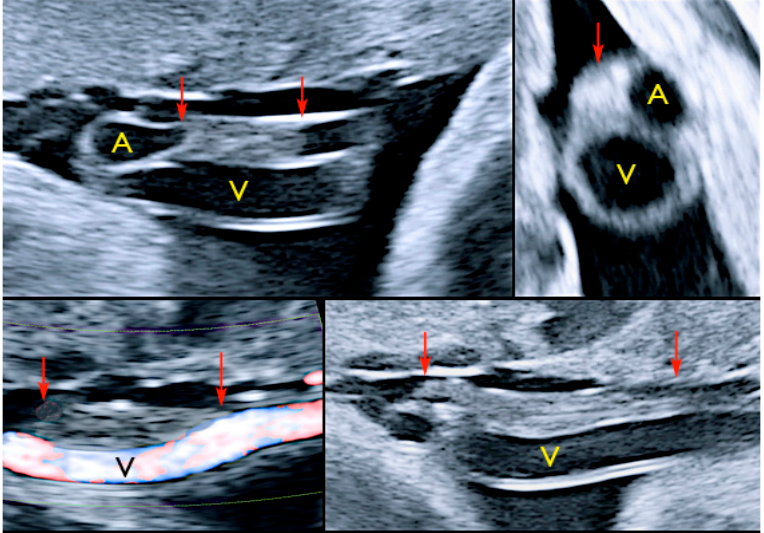
Figure 33. Pregnancy at 32, 34 and 35 week’s gestation. Two-dimensional ultrasound in longitudinal and axial scan of the umbilical cord. A moderate echogenicity corresponds to segmental thrombosis of an umbilical artery. The thrombosis zone is indicated by red arrows and the progressive extension is further delimited by arrows (Legend: A: umbilical artery; V: umbilical vein).